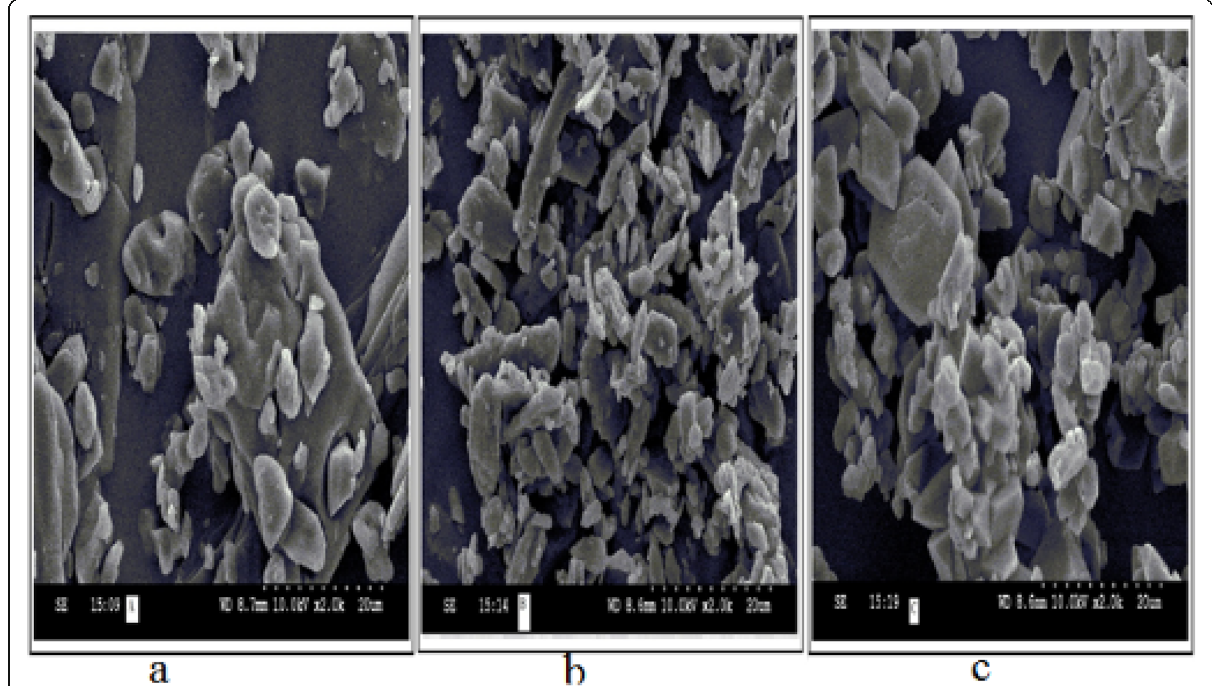
Fig. 8 SEM images of a pure CAR, b pure HCT, and c